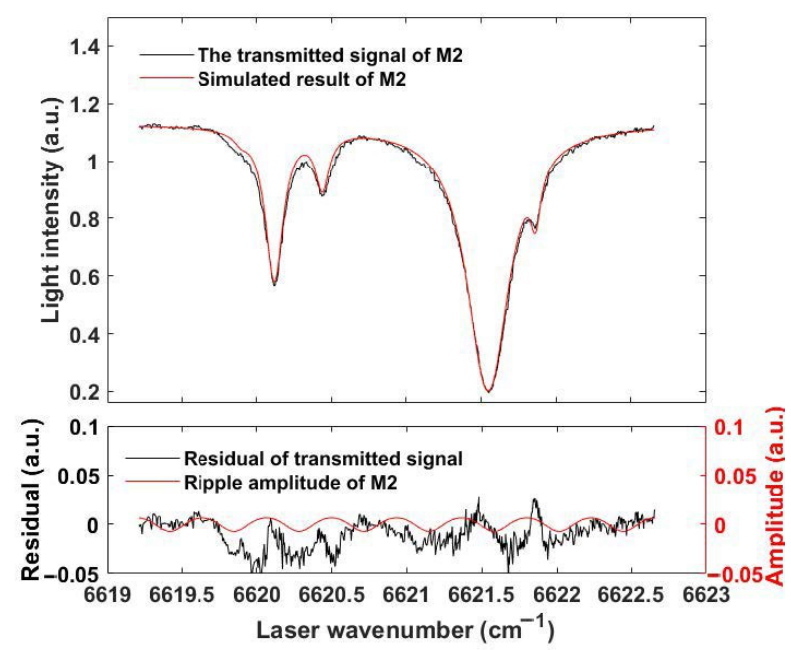
Figure 6. The cavity transmitted light signal of M2 (black). The simulated transmitted light of M2 (red) without etalon effect. The simulated results without etalon effect are based on Equation (3) and HITRAN 2020 (P= 1.0 atm, T = 25 °C). The bottom shows the residuals of the measured signal (black) and the ripple amplitude of M2.